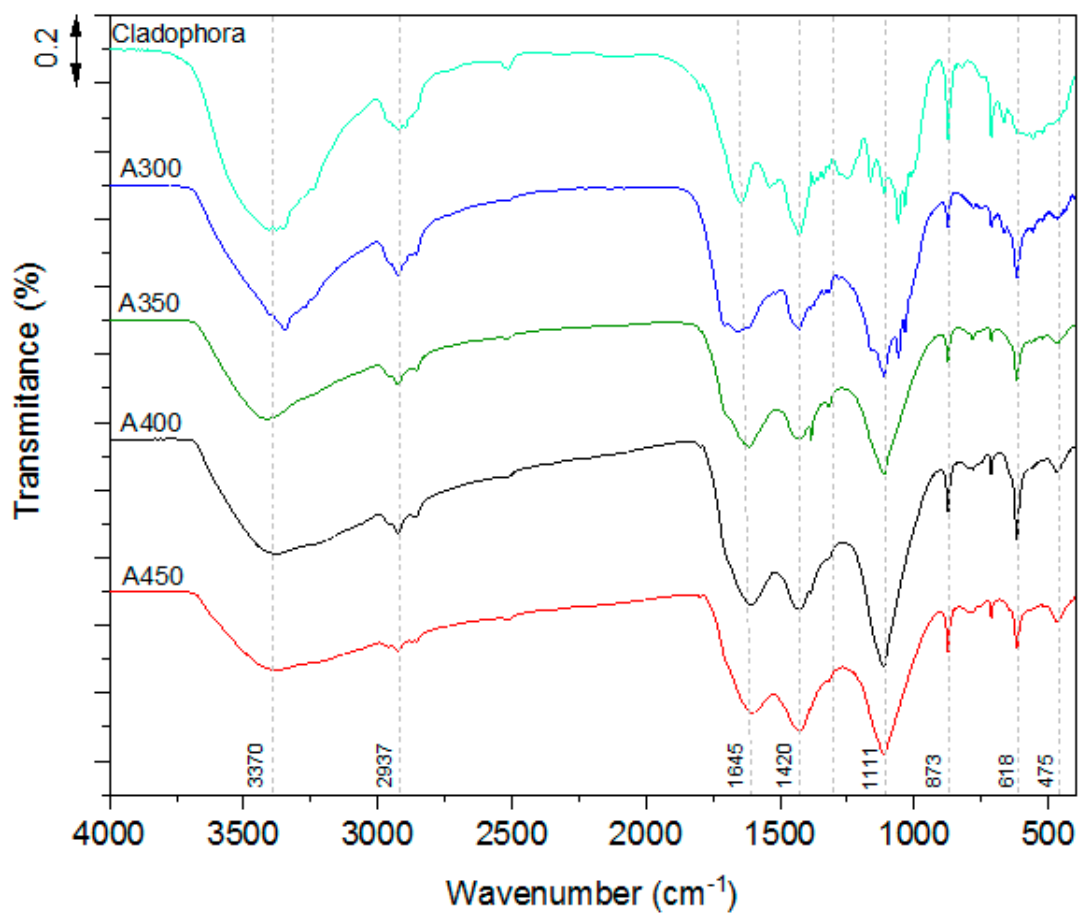
Figure 3. Fourier-transform infrared spectra of biochar formed at different temperatures.